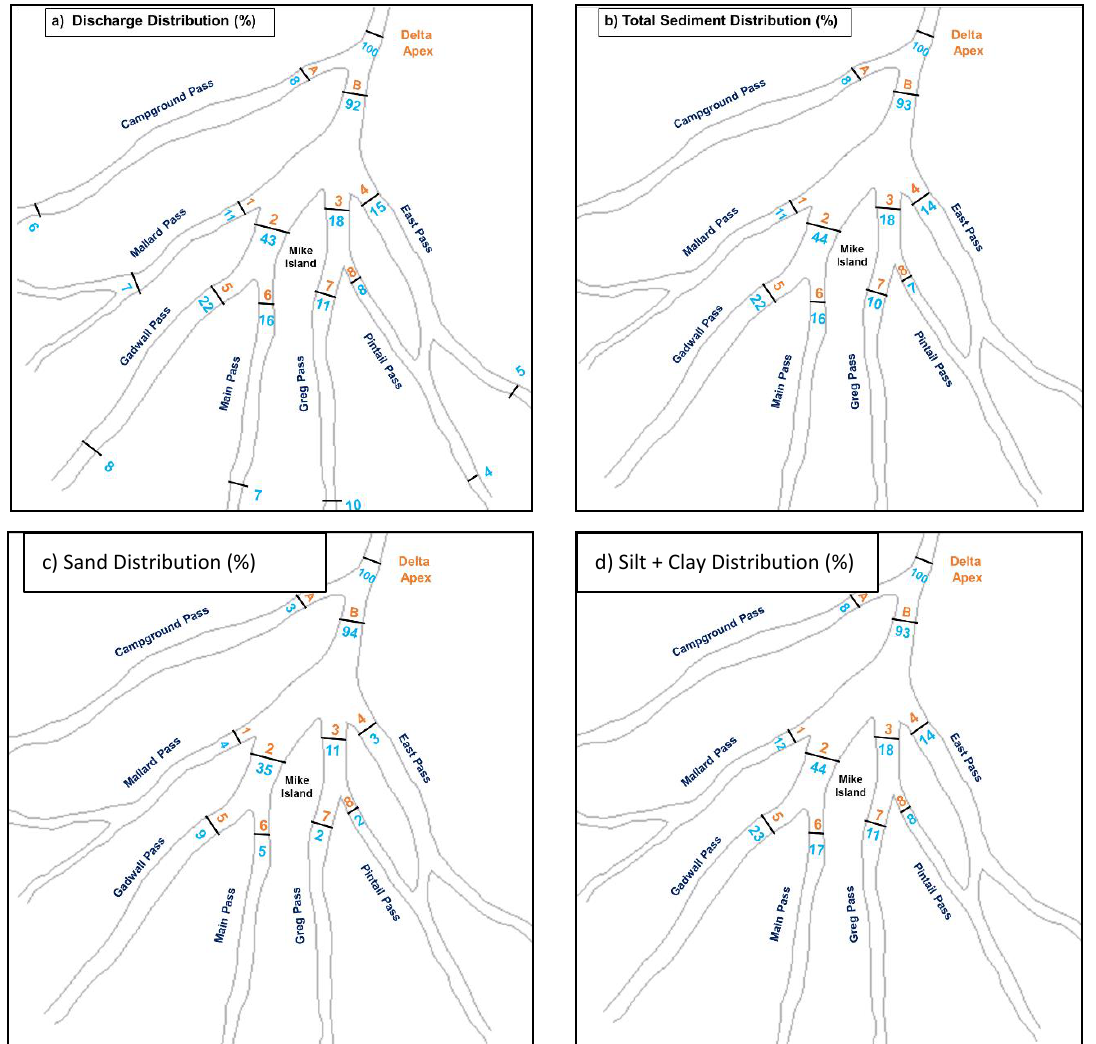
Figure 11. Simulated distribution of water, total sediment, sand, and fine sediment transport at the channel networks for a river flood event (% are calculated with respect to the value at the delta apex). Text in orange is a naming convention of the channels whereas text in blue color represents percentage values of flow and sediment distribution.